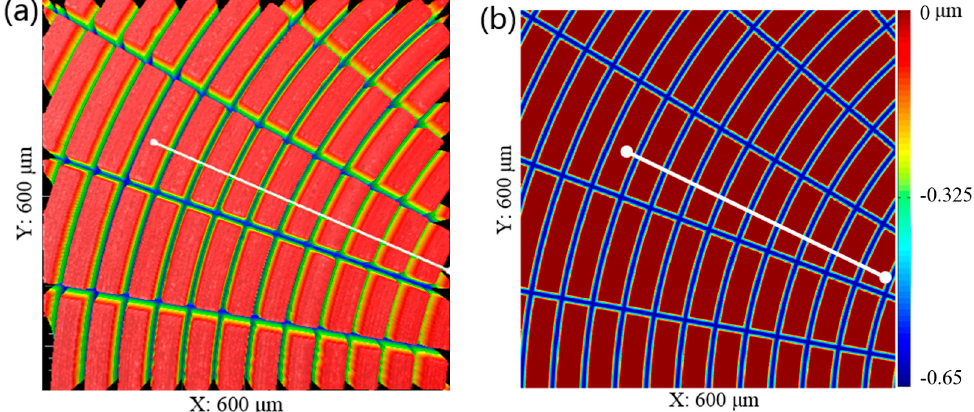
Figure 9. Surface topography of the workpiece machined by MPC3 ( a ) Measured with Zygo Nexview™ 3D Optical Surface Profiler ( b ) Simulated by Matlab 2017.